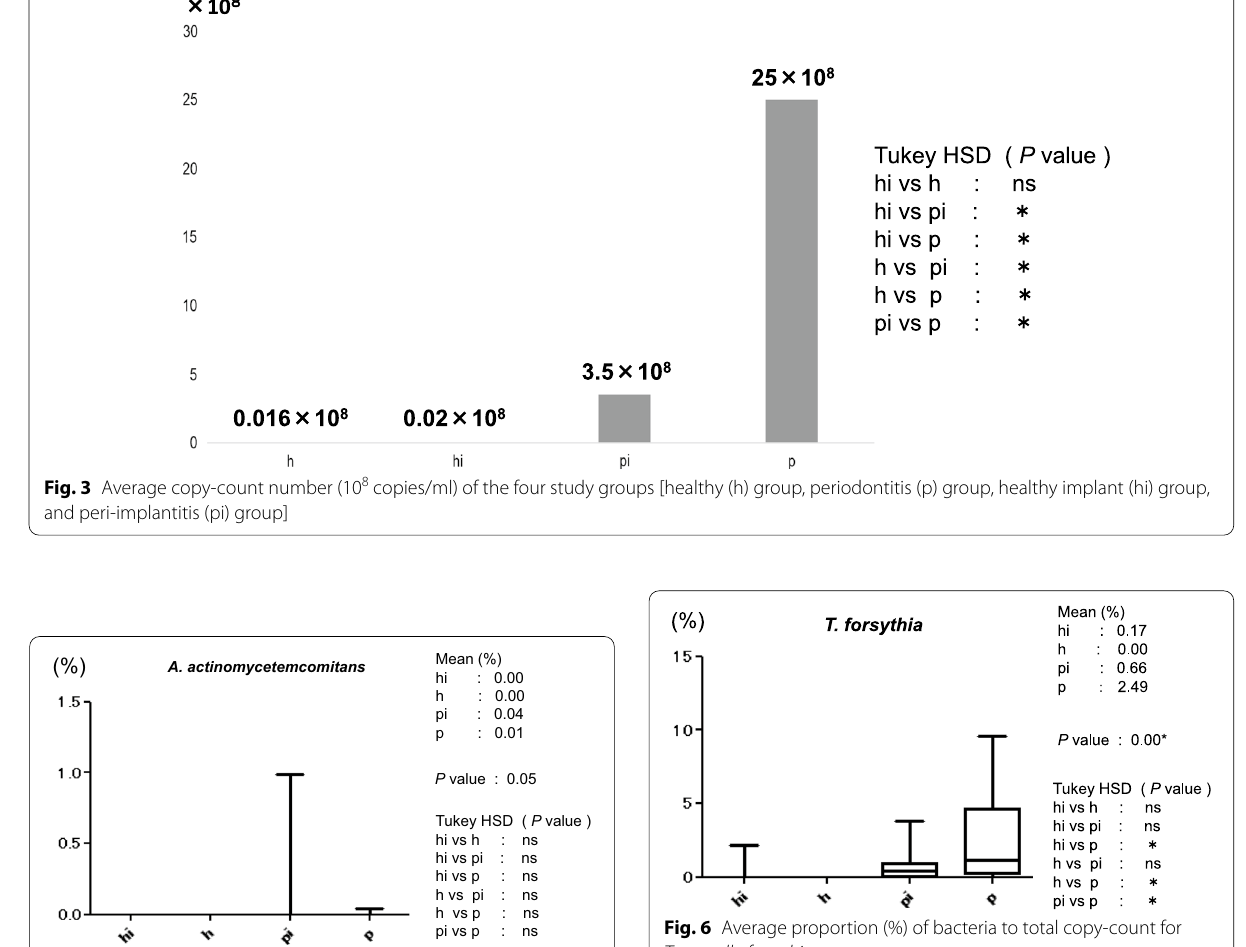
Fig. 4 Average proportion (%) of bacteria to total copy-count for Aggregatibacter actinomycetemcomitans